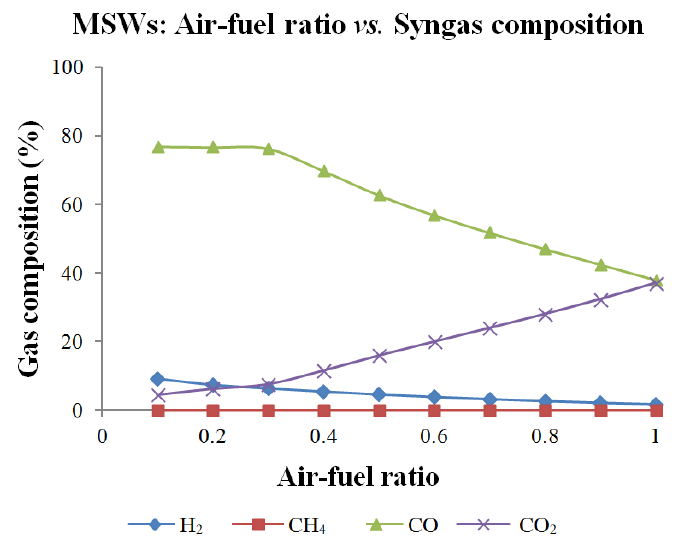
Figure 3. Effect of air-fuel ratio for municipal solid wastes (MSWs) (gasifier temperature: 700 °C).